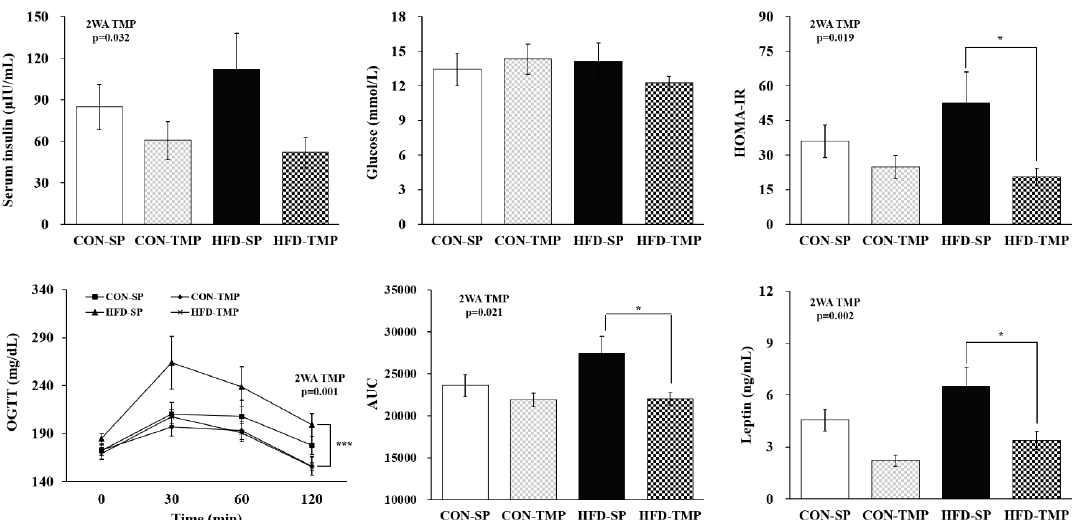
Figure 2. Serum insulin, glucose, and leptin levels; HOMA-IR; and OGTT. The values are expressed as the means ± S.E. (n = 10 per group). * p < 0.05, *** p < 0.001 vs. HFD-SP by Student’s t -test. 2WA FAT, fat diet effect in two-way ANOVA ( p < 0.05); 2WA TMP, TMP effect in two-way ANOVA ( p < 0.05); CON-SP, control diet containing SP; CON-TMP, control diet containing TMP; HFD-SP, high-fat diet containing SP; HFD-TMP, high-fat diet containing TMP; HOMA-IR, homeostasis model assessment of insulin resistance; OGTT, oral glucose tolerance test.